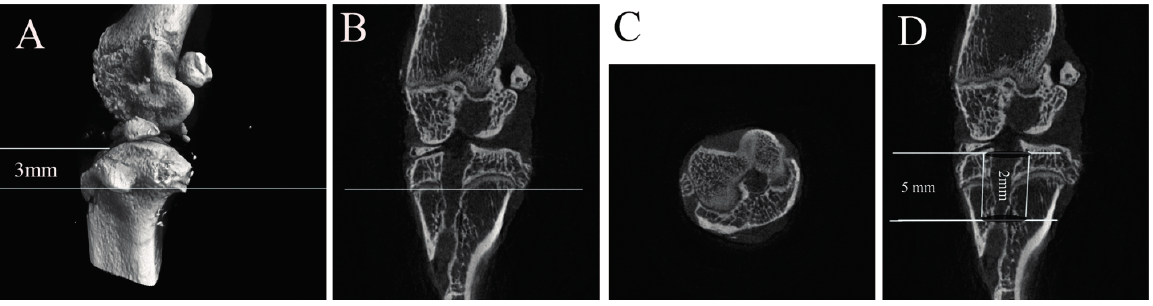
Figure 5. A sketch map of micro-CT evaluations: ( A ) observation of the vertical plane of the axis of the bone tunnel at a 3-mm depth from the tibial joint surface in a three-dimensional reconstruction micro-CT image; ( B ) the vertical plane of the axis of the bone tunnel at a 3-mm depth from the tibial joint surface in a sagittal view of the micro-CT image; ( C ) the areas of the bone tunnel at a 3-mm depth from the tibial joint were measured with Image-Pro Plus; ( D ) BMD, BV/TV, BS/BV, BS/TV, Tb.Th, Tb.N and Tb.Sp of a cylinder scope, including the bone tunnel with a 2.0-mm diameter and depth of 5.0-mm from the joint surface, were